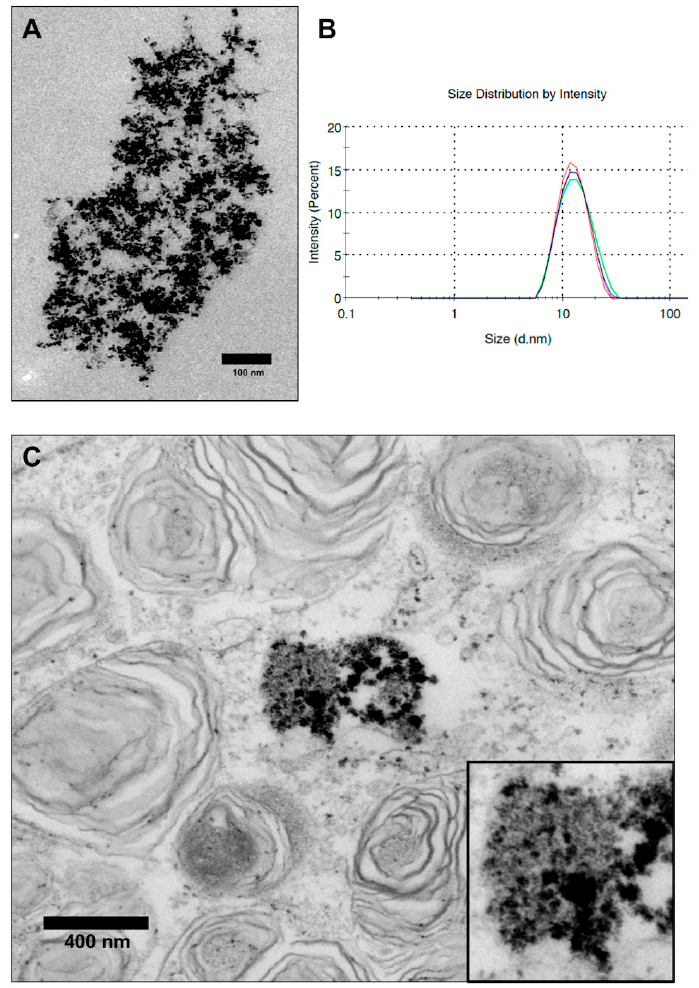
Figure 1. VSOP morphology, characterization and intracellular accumulation: ( A ): Transmission Electron Microscopy (TEM) image of VSOP C200. ( B ): Size distribution diagram of VSOP C200 determined by dynamic light scattering. ( C ): TEM image of intravesicular accumulation of VSOPs in the cytoplasm. The insert shows the intravesicular particles at a higher magnification. The scale bars represent 100 nm ( A) and 400 nm ( B ) respectively.